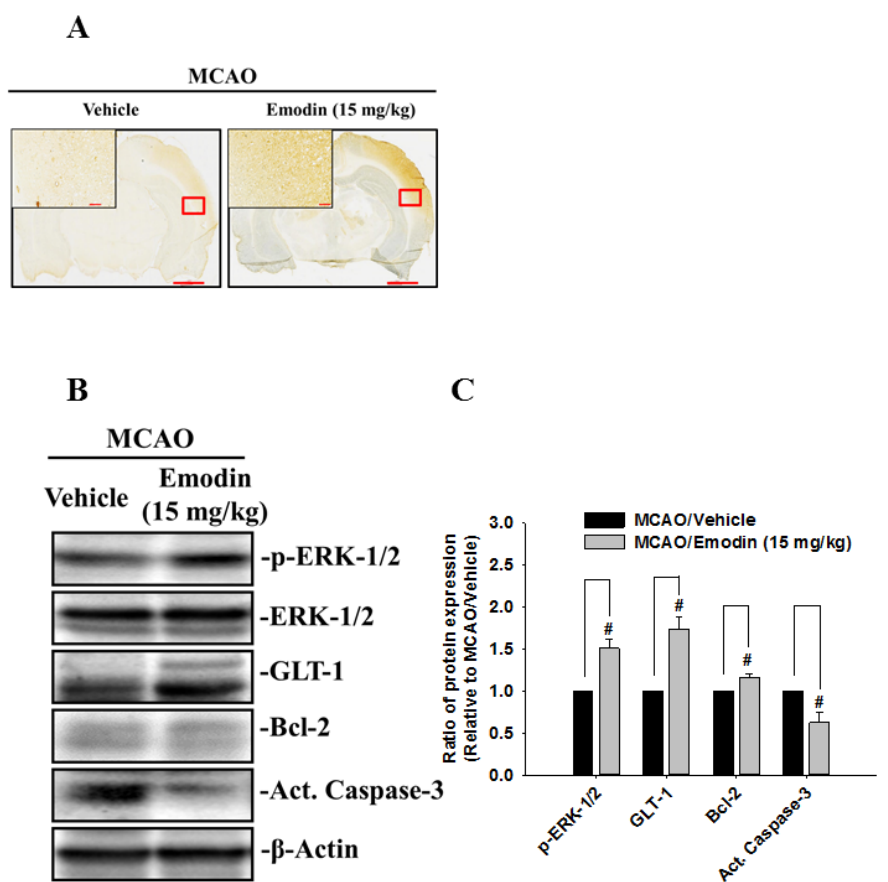
Figure 4. Emodin increases GLT-1 protein expression in rat brain sections after MCAO. ( A ) GLT-1 was detected by immunohistochemical staining of rat brain slices after MCAO surgery. Red box denotes area shown in higher magnification inset on the upper left. Scale bar of low-power photomicrographs is 2 mm. Scale bar of high-power photomicrographs (higher left corner) is 100 µ m. ( B ) Expression of p-ERK-1 / 2, GLT-1, Bcl-2, and Act. Caspase-3 were determined by western blotting of rat brain cortex. ( C ) Bar graph showing semi-quantified densitometry. The ratio of p-ERK-1 / 2 was normalized to the levels of ERK-1 / 2 and β -Actin. # indicates comparison with MCAO / vehicle and MCAO / Emodin. # p < 0.05 using Student’s t -test. ( n = 3).